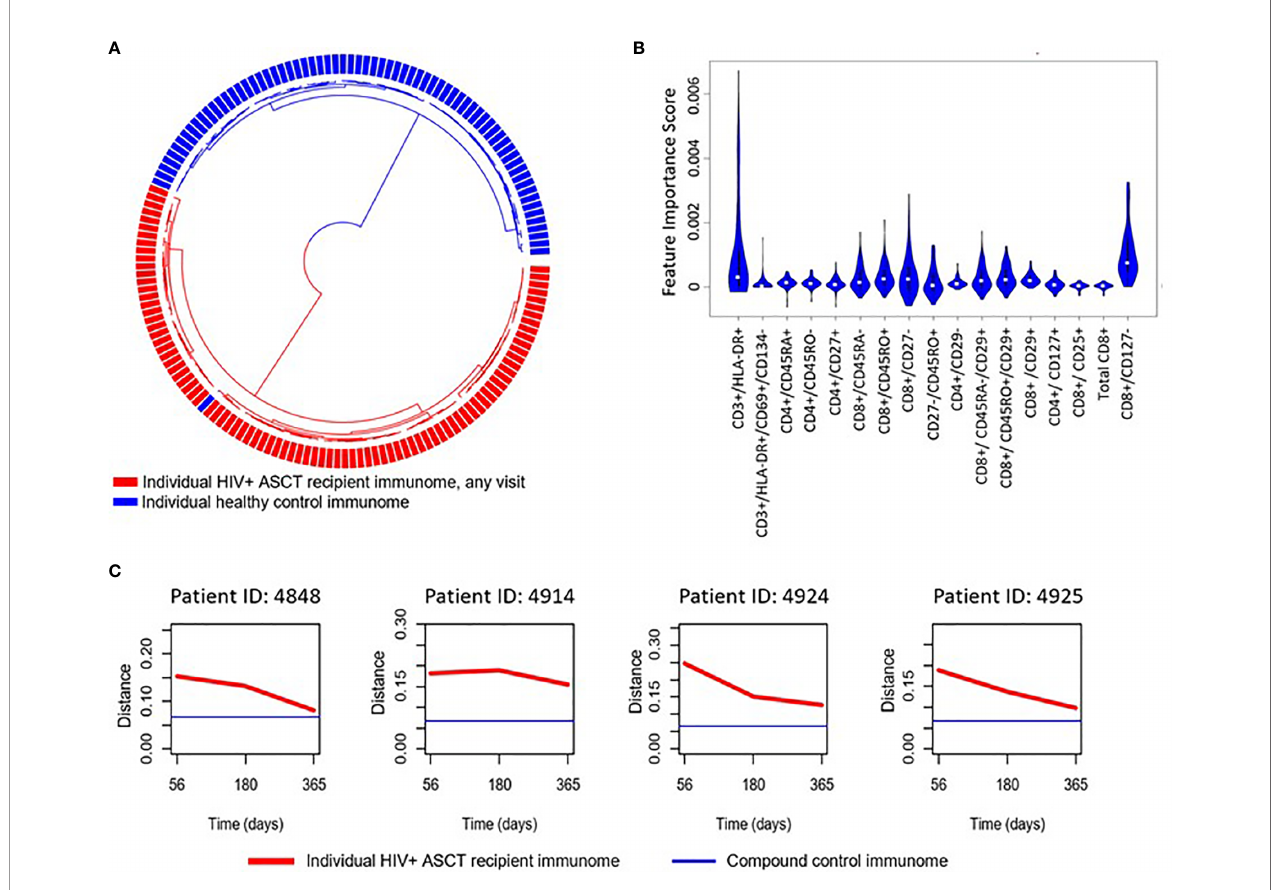
FIGURE 4 | (A) Circularized dendrogram shows results of the I-index analysis of HIV(+) AHCT recipients (all visits) and controls: distance between individual cases is proportional to the degree of difference between patient and control lymphocyte populations. (B) Violin plot shows the impact of speci fi c immune subsets on the degree of difference between HIV(+) (all visits) and control cohorts. Immune cell subsets with signi fi cant FIS are shown. (C) Evolution of the distance of randomly selected HIV(+) ASCT recipients ’ lymphocyte populations (red line) to a set of compound control lymphocyte populations (blue line), where distance from control is de fi ned as 1 -